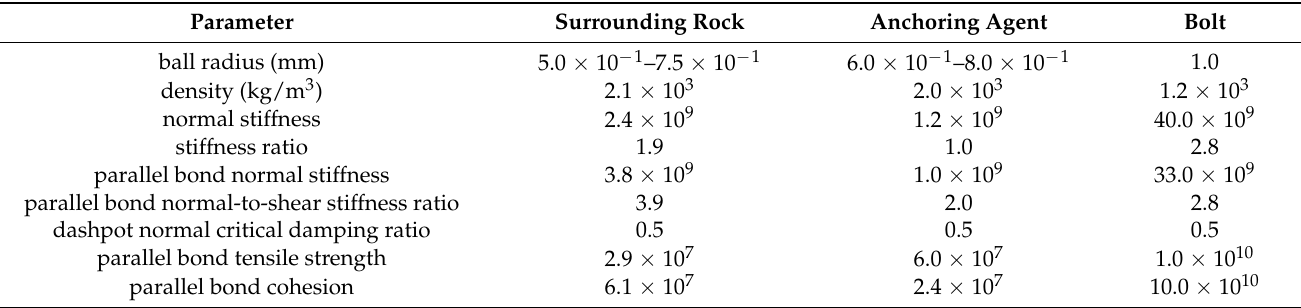
Table 1. Main parameters of